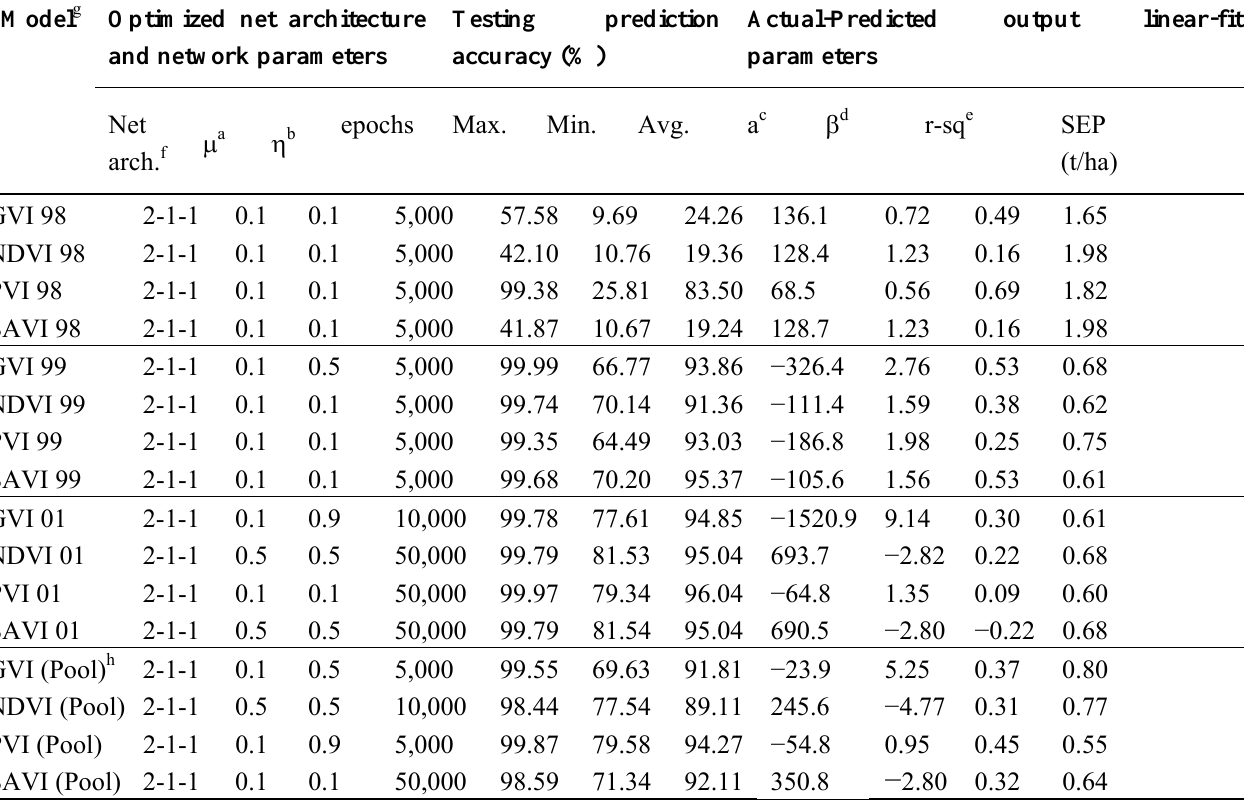
Table 2. The performance of hybrid VI-BPNN models using original